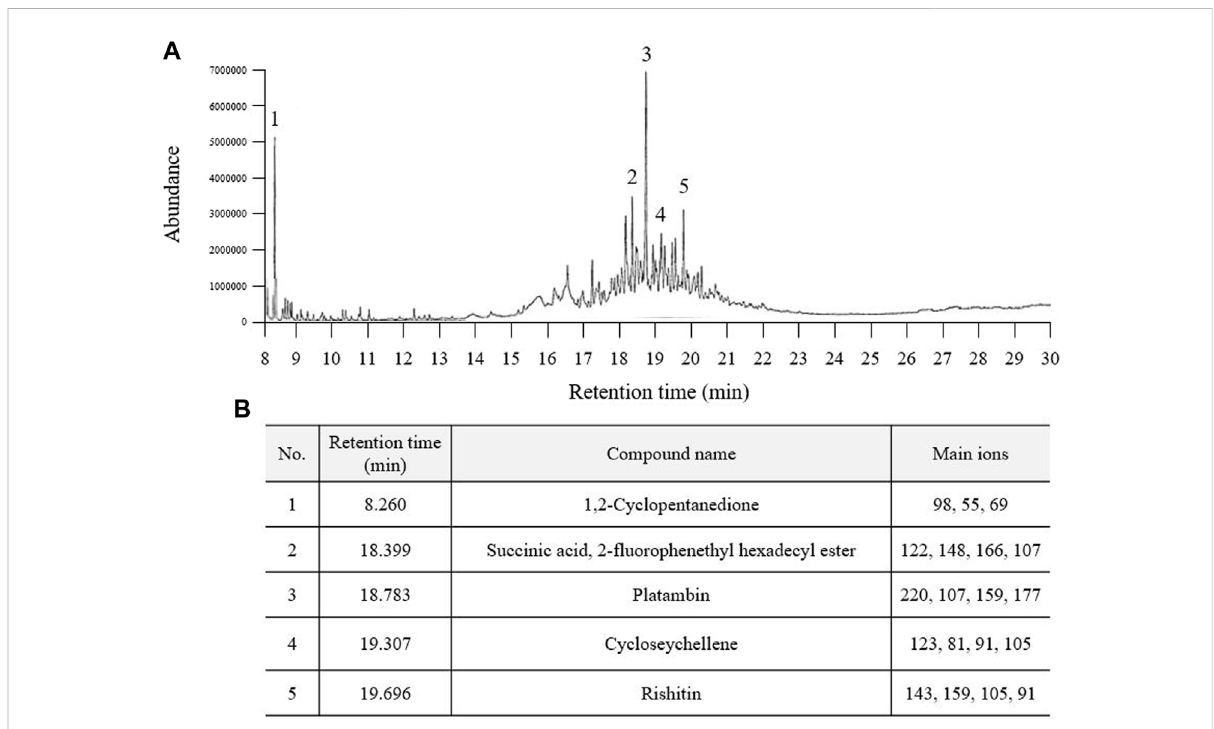
FIGURE 1 Fingerprinting analysis of Pinus spp. extract (PSE). PSE (30% ethanol extract) was applied to GC-MS and a chromatogram was obtained (A) . Five prominent peaks were detected at each retention time (B)